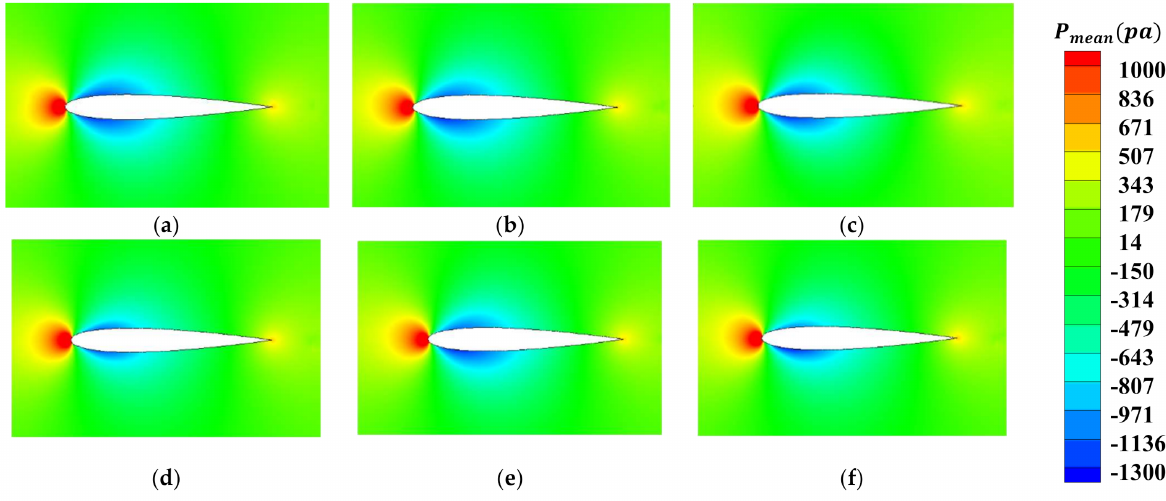
Figure 15. Distribution of average pressure variations after applying control: ( a ) A/C = 0, ( b ) A/C = 0.02, ( c ) A/C = 0.04, ( d ) A/C = 0.06, ( e ) A/C = 0.08, ( f ) A/C = 0.1. It should be noted that the asymmetry of the average pressure distribution is due to the displacement movement and the asymmetry of the center of the cylinder and the airfoil in the direction perpendicular to the flow (2